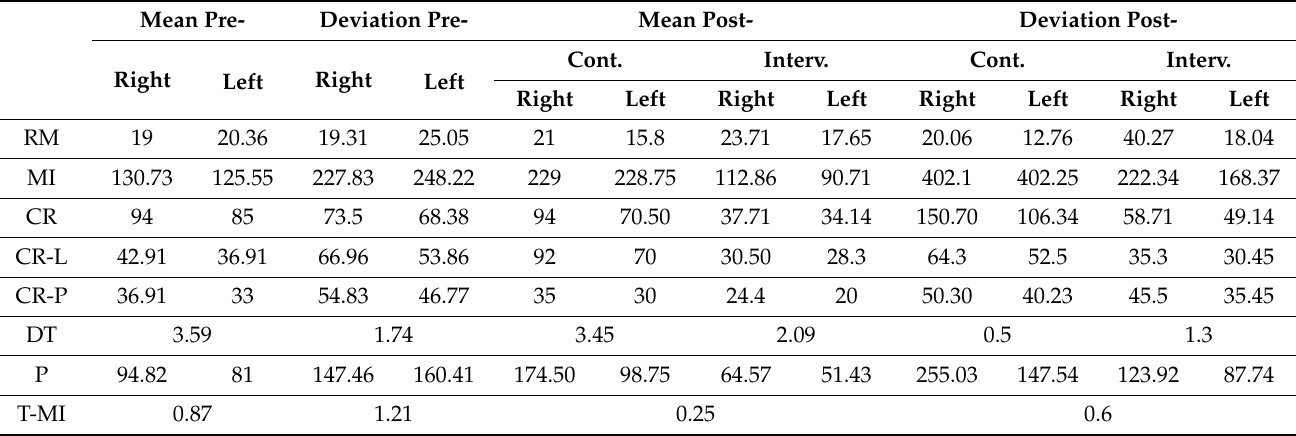
Table 1. Mean muscle activity value comparison in microvolts ( µ V) of the masseter muscle in different jaw positions, where RM is relaxed mandible, MI is maximum intercuspation position, CR is jaw in centric relation according to Dawson’s bimanual manipulation, CR-L is centric relation measured using Long’s laminae, CR-P is centric relation obtained in the position of the first dental contact, DT is jaw disclusion time, P is jaw protrusion position and T-MI is time needed to reach the position of maximum intercuspation. We were able to clearly observe a reduction in activity in the right (19 µ V) and left (20.36 µ V) masseter muscles in a relaxed jaw position before needling the trigger points. After waiting 10 min post-needling and repeating the same measurement, we obtained values of